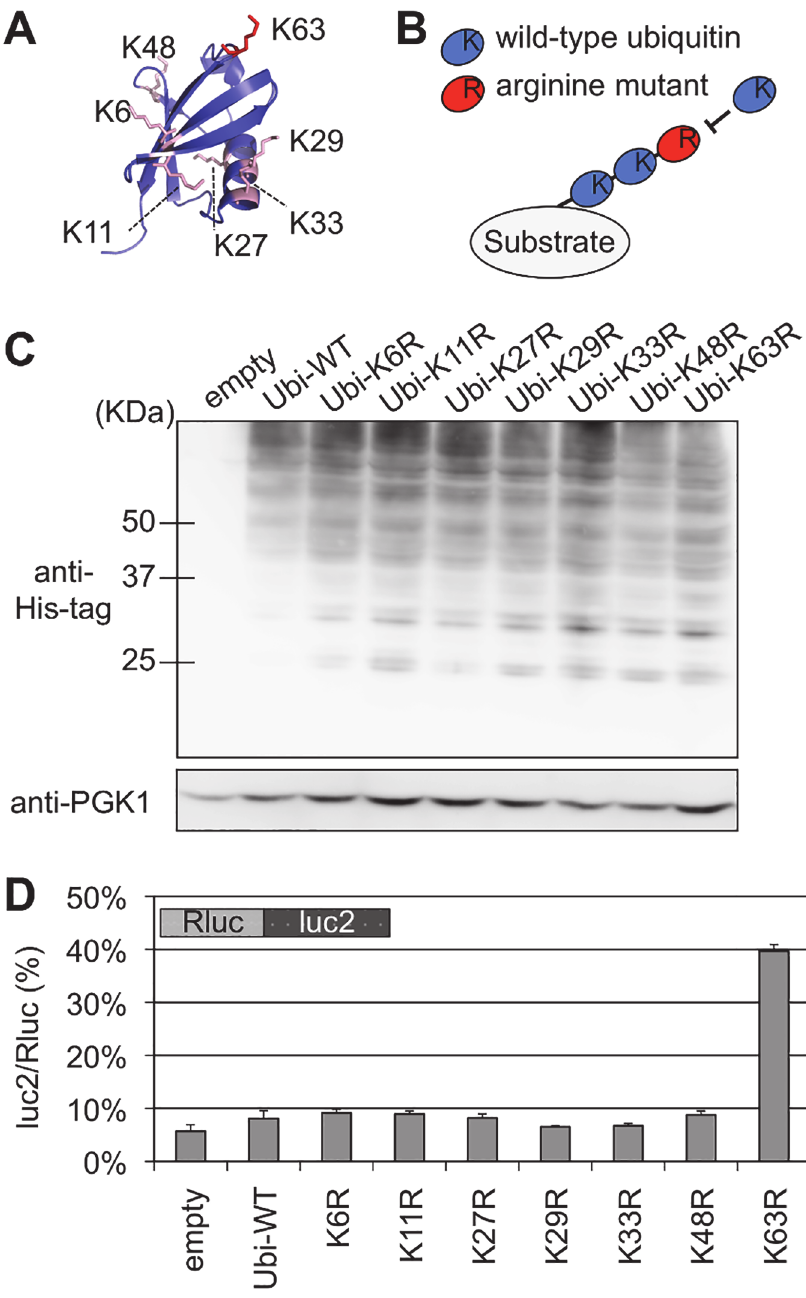
Fig 2. Effect of K63 polyubiquitination on the quality control for stalled translation. (A) Structure of Ubiquitin protein and location of the lysine residues for polyubiquitination [id: 1UBQ]. K63 (red) and other lysine residues (pink) are shown in sticks. The structural model was generated using MolFeat version 3.5 (Fiatlux, Tokyo, Japan). (B) Schematic illustration for the inhibition of polyubiquitination by arginine mutants. Arginine mutants were expressed from expression plasmids in yeast cells harboring endogenous ubiquitin genes on its genome. An incorporation of an arginine mutant into the (poly-) ubiquitin chain terminates further elongation. (C) Cellular ubiquitination levels of wild-type and ubiquitin mutants with a single arginine substitution (K6R, K11R, K27R, K29R, K33R, K48R, K63R). Ubiquitin genes were fused with His-tag and expressed from plasmids in the wild-type strain (BY4727). Cellular ubiquitination levels were detected by antibody for His-tag. PGK antibody was used as loading control. (D) Dual luciferase assay for the effects of arginine mutants of ubiquitin protein on the Rluc-CGA x12-luc2 reporter. Plasmids that included ubiquitin arginine mutants were introduced into a wild-type strain (HRKW-2). Ubi-WT indicates wild-type ubiquitin. Average luc2/Rluc ratios and standard deviations were determined from three independent